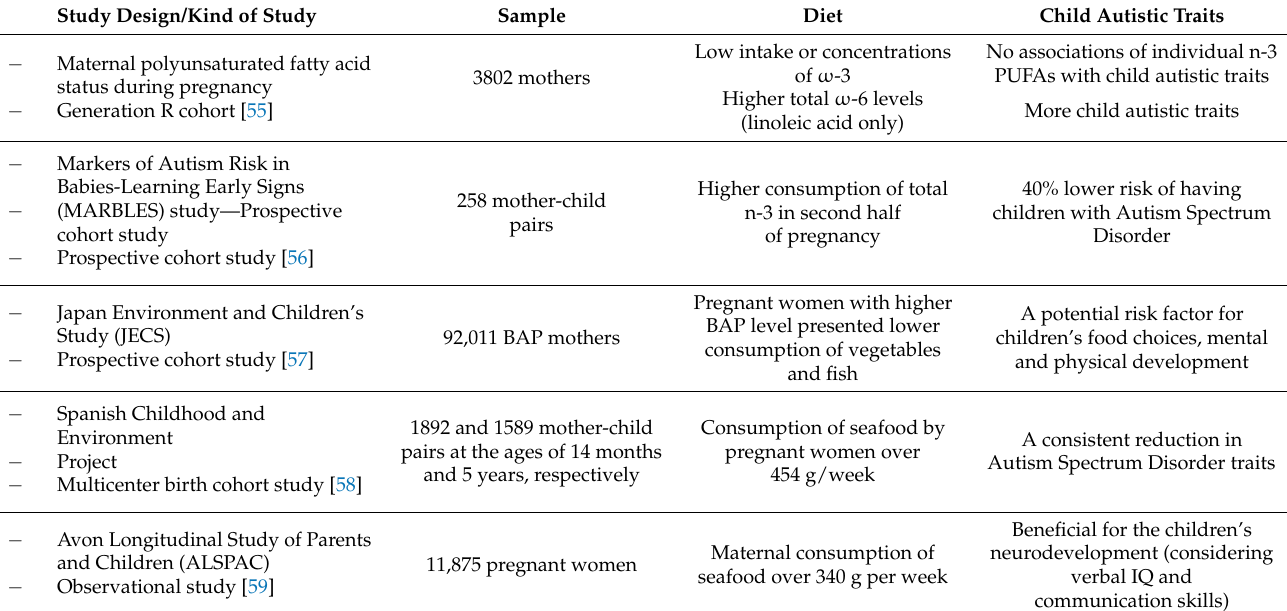
Table 1. Associations of long-chain polyunsaturated fatty acid (LCPUFA) intake during pregnancy with child autistic